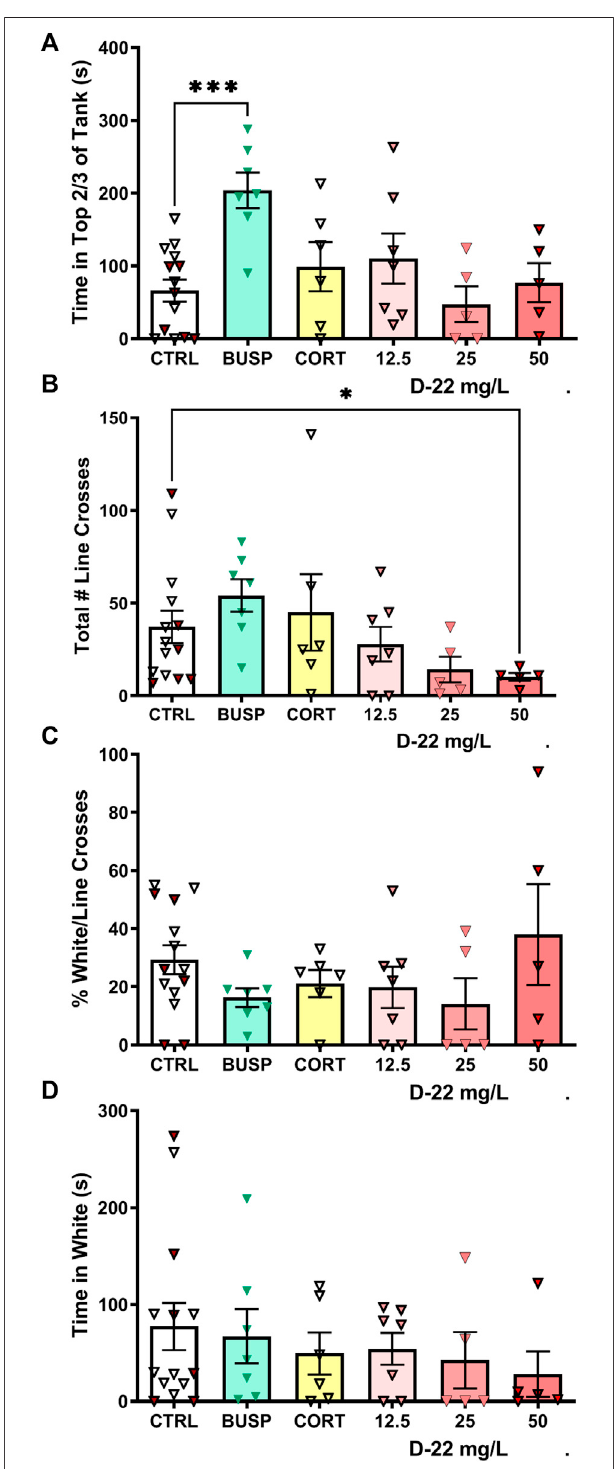
FIGURE 2 | Acute effects of D-22 on behaviors in novel environment- based anxiety tests. A total of 45 zebra fi sh were tested with sample sizes ranging from 5 to 15 fi sh with both males and females in every group. (A) Only the anti-anxiety drug buspirone increased the amount of time zebra fi sh